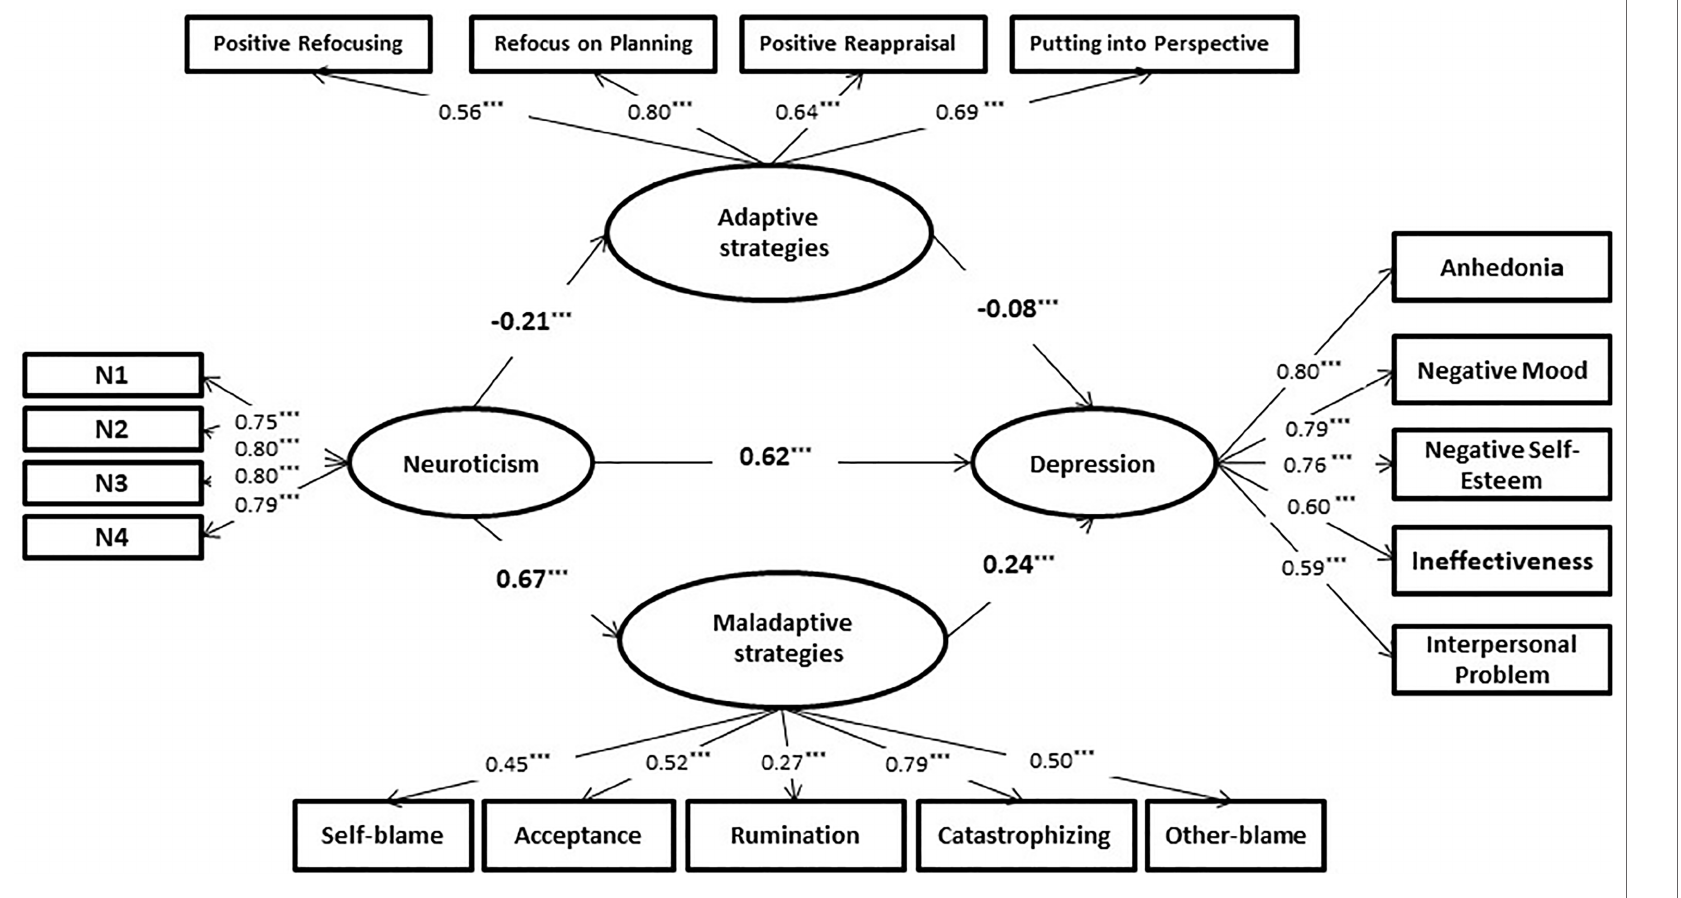
FIGURE 1 | Standardized path coef fi cients of the mediation model. *** p <